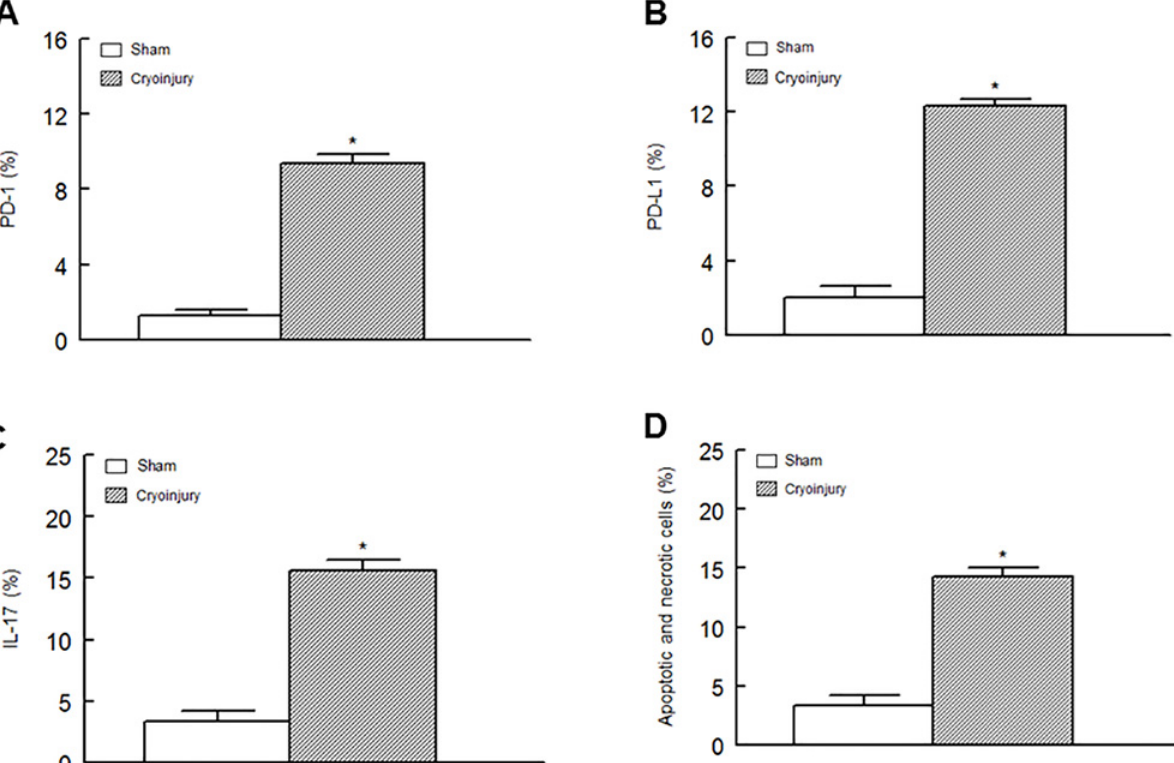
Fig 8. Hearts of male mice were subjected to cryoinjury or sham operation as described under Methods. Thereafter, cardiac cells were subjected to flow cytometry studies which revealed significant increases in PD-1, PD-L1 and IL-17 positive cells (panels A-C, respectively) in association with significant increase in apoptotic and necrotic cell death (panel D). Data are means ± SEM of n = 4 sham and n = 7 cryoinjury animals. * p < 0.05 compared to the sham group.